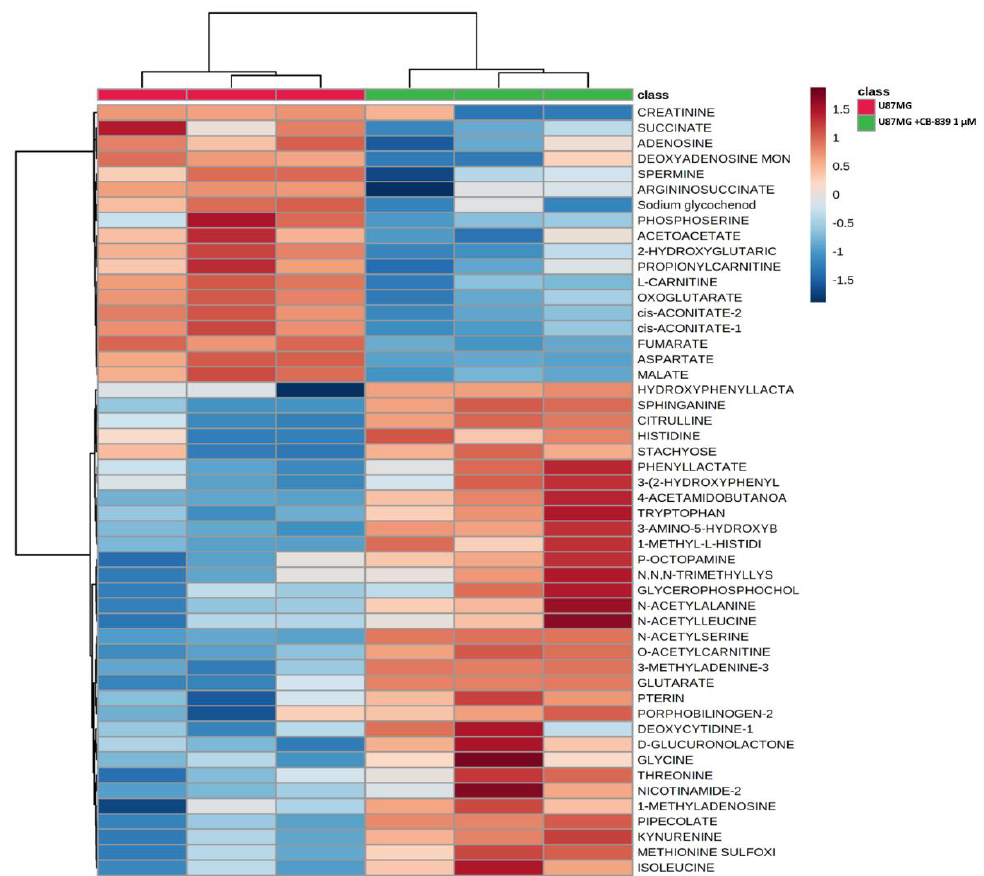
Figure 6. Metabolomic changes elicited by CB-839 are depicted on a representative hierarchical clustering analysis of key molecules in the U87MG glioma cell line. The heat map shows the top 50 differentially altered metabolites in GBM cells exposed for 24 h to 1 μM CB -839. The samples were run in triplicate. For more details, see Section 2.